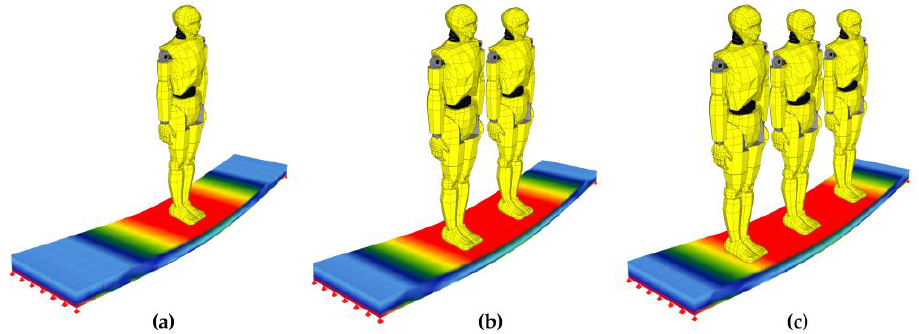
Figure 15. Numerical simulations of the implementation of excited vibrations in the form of rhythmic jumps performed by: ( a ) one person, ( b ) two people, ( c ) three people.